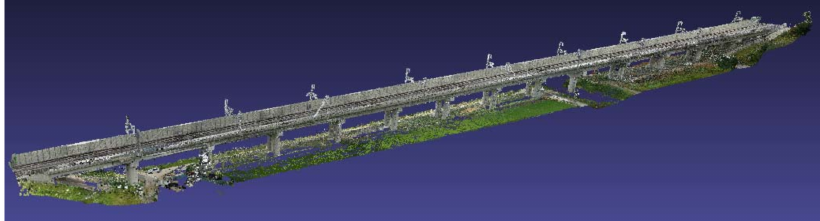
Figure 21. Point cloud data of Osong test track fifth bridge obtained by